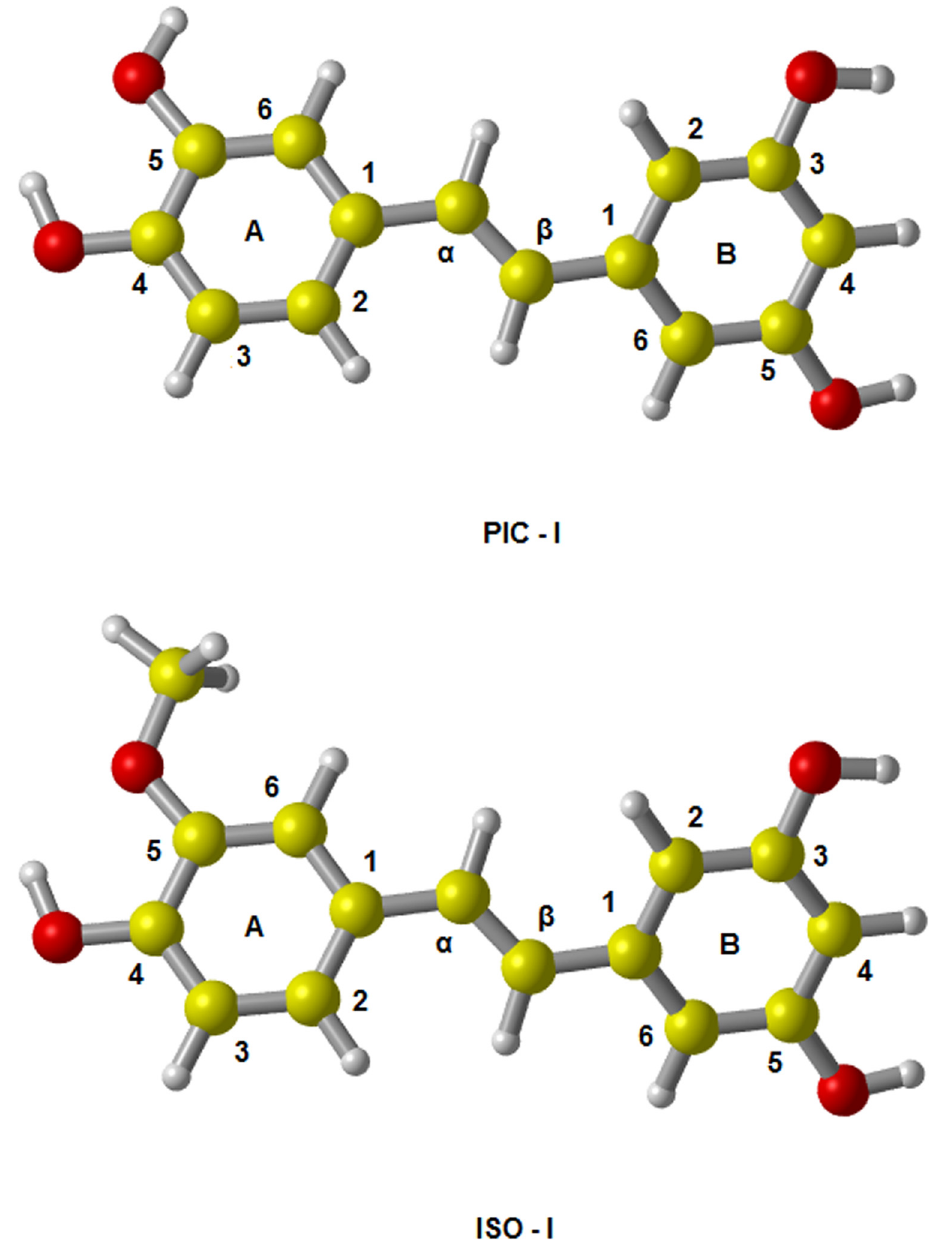
Fig 11. The optimized geometries of PIC-I and ISO-I in the gas phase. The dihedral angle between two benzene rings of PIC-I is 179.87°, and the dihedral angle between two benzene rings of ISO-I is -179.99°.